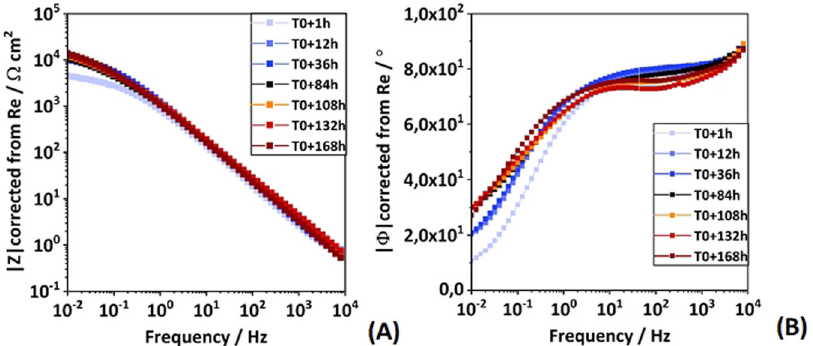
Fig. 8 Bode diagrams measured regularly during 7 days of continuous cathodic polarization at − 0.8 V vs SCE of DH36 steel. The modulus in ( A ) and phase in ( B ) are plotted in function of the frequency and corrected for Re (electrolyte resistance). Measurements are made after 1 h, 12 h, 36 h, 84 h, 108 h, 132 h, and 168 h of immersion at 20 °C, under static condition and natural aeration.